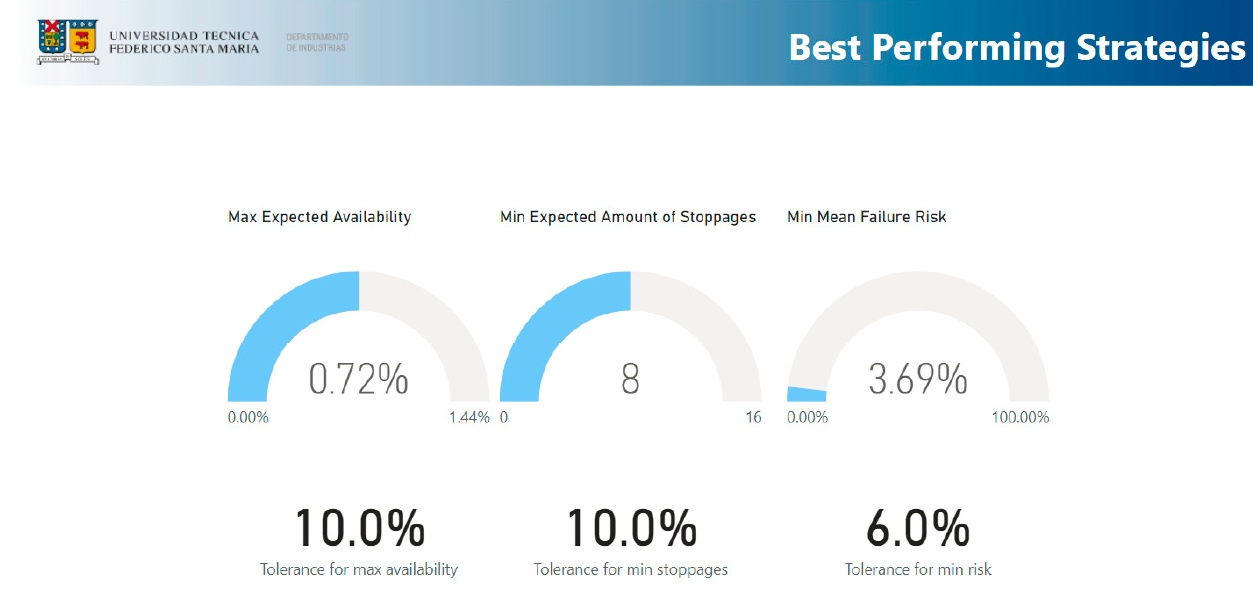
Figure 3. Best-performing strategies section.